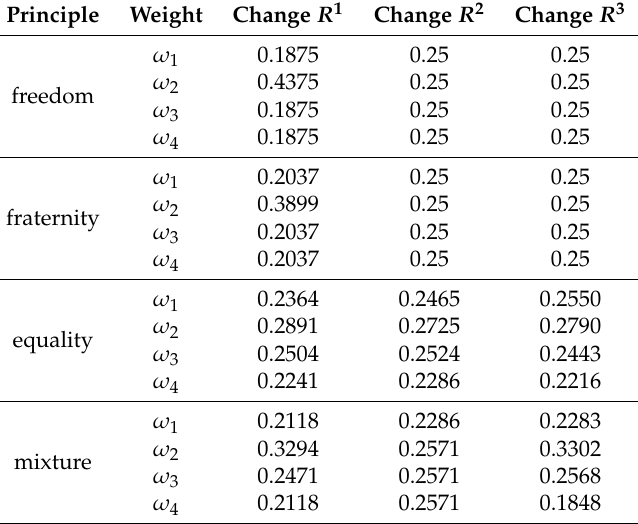
Table 4. Priorities determined using the modified matrices and II